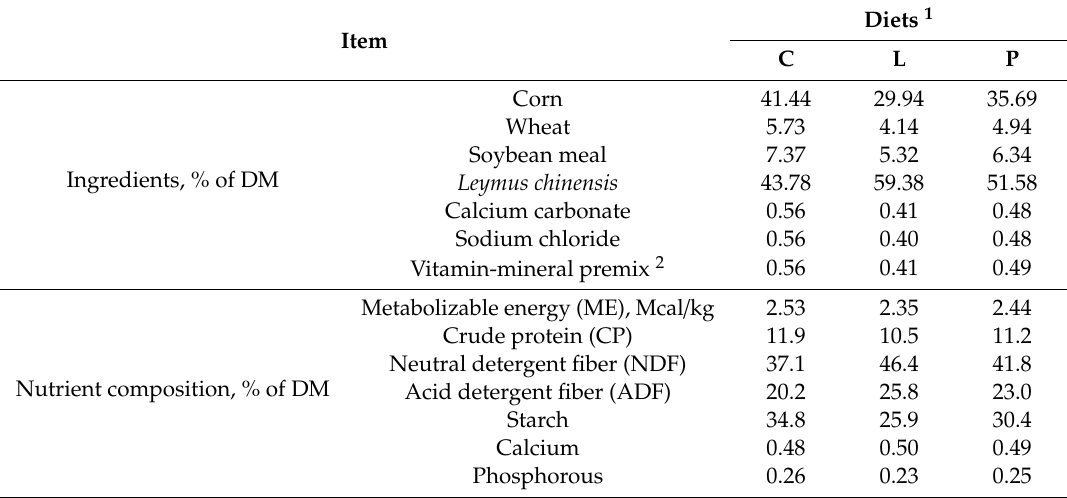
Table 1. Ingredients and nutrient composition of the experimental and pre-experimental diets.